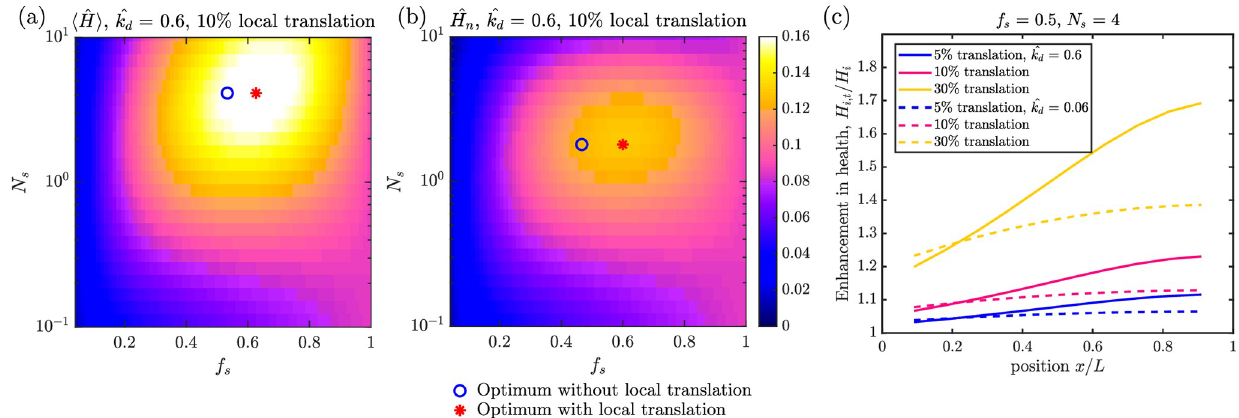
Fig 6. Mitochondrial health in the presence of local translation. (a) Average health across all demand regions as a function of fraction of stopped mitochondria ( f s ) and number of stopping events ( N s ), for high decay rate ( ^ k ) and local translation level α = 10%. Markers show the optimal parameter d values with (red asterisk) and without (blue circle) local translation. (b) Corresponding mitochondrial health at the most distal demand site. (c) Enhancement of health levels at each demand site in the presence ( H i , t ) versus absence ( H i ) of local translation, for one set of transport parameters, ( f s = 0.5, , and three different local translation levels ( α ). N s = 0.4), two decay rates ^ k d